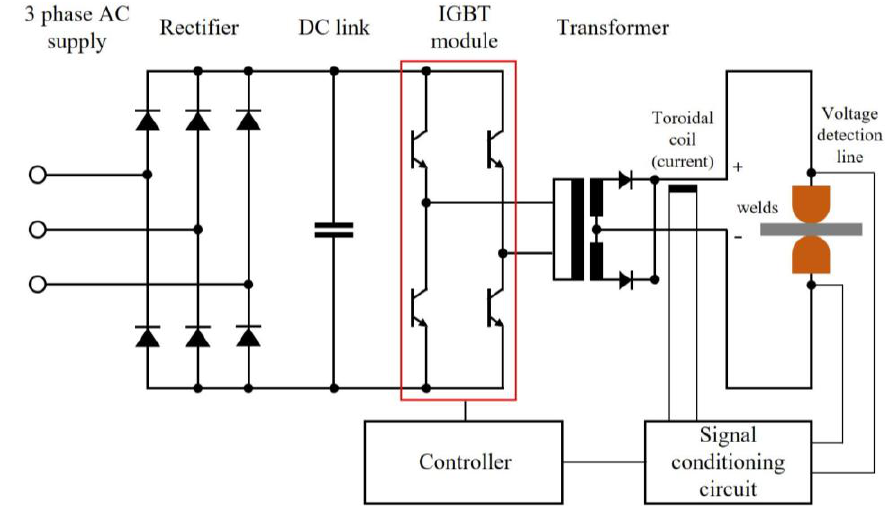
Figure 3. Proposed reference-based adaptive resistance spot welding (RSW) system.